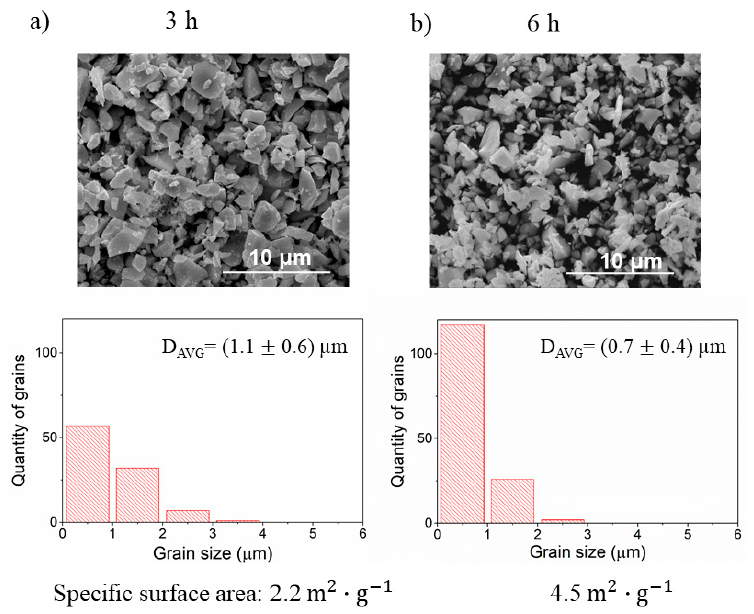
Figure 12. The SEM images, grain size analysis, and specific surface area of the powders milled for ( a ) 3 h and ( b ) 6